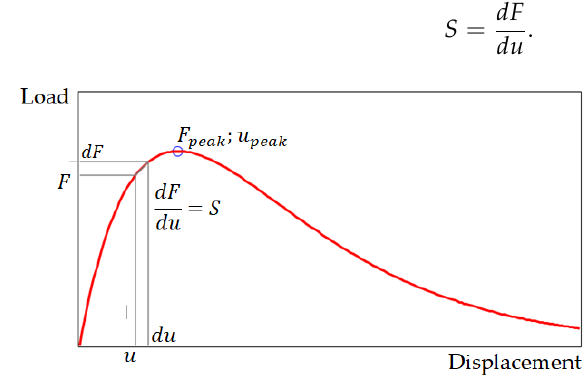
Figure 3. Load–displacement pattern.